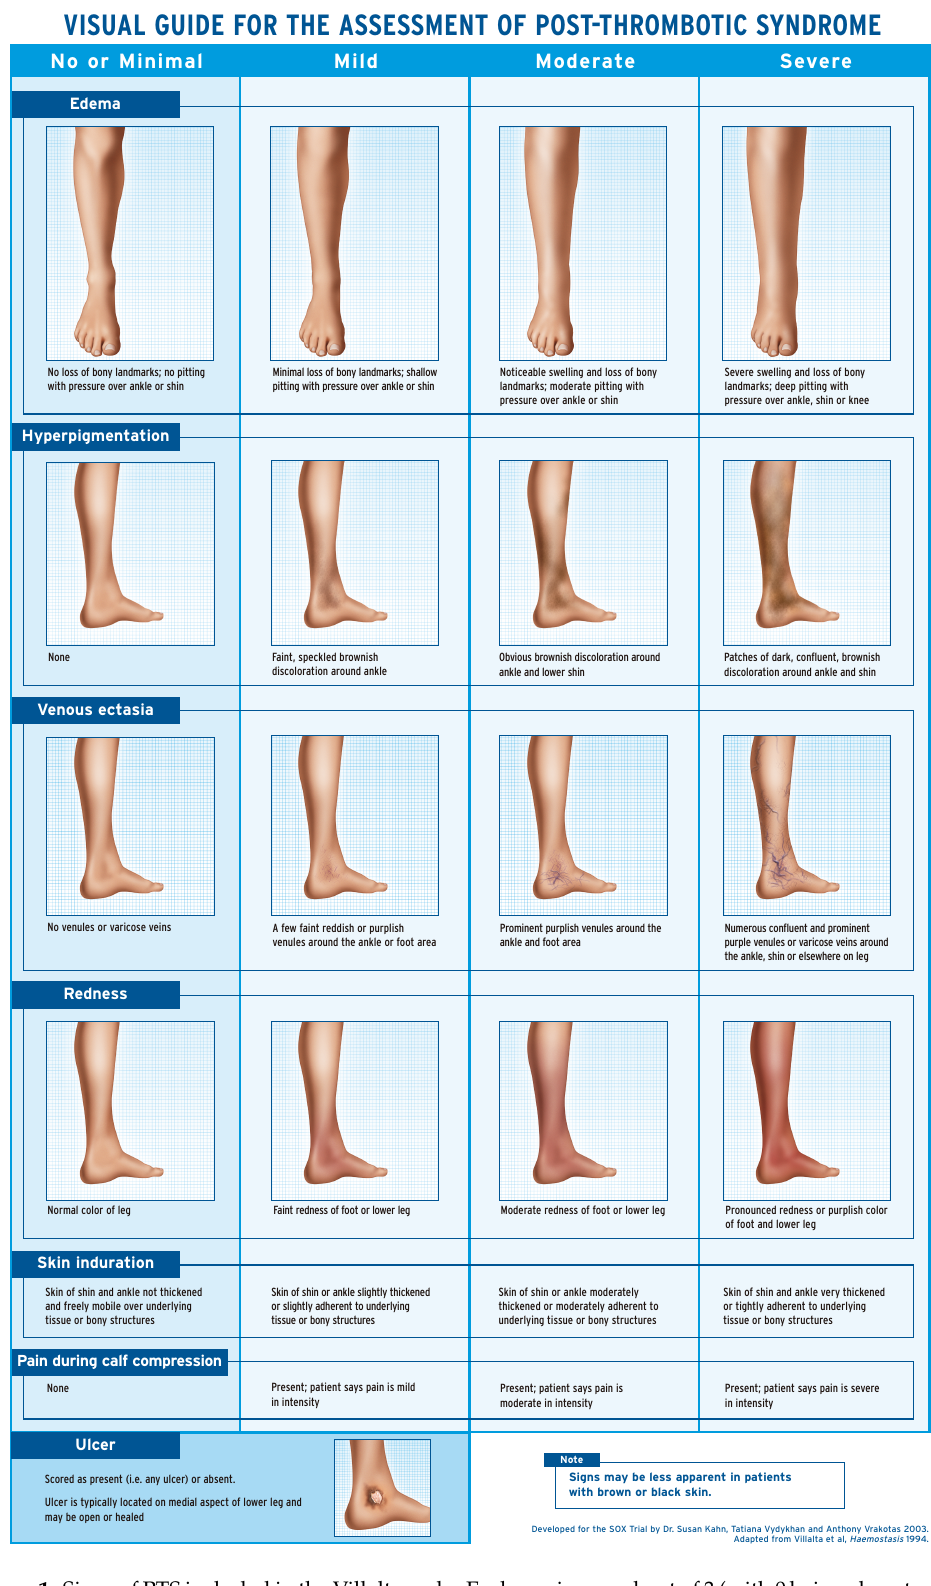
Figure 1. Signs of PTS included in the Villalta scale. Each one is scored out of 3 (with 0 being absent and 3 being most severe). Symptoms are also scored out of 3, and include pain, cramps, heaviness, paresthesia and pruritus. Scores 5–9 represent mild PTS, 10–14 is moderate and ≥ 15 is severe. The presence of a venous ulcer automatically classifies the PTS as severe. The Villalta scale score is non-specific and does not distinguish pre-existing chronic venous insu ffi ciency from